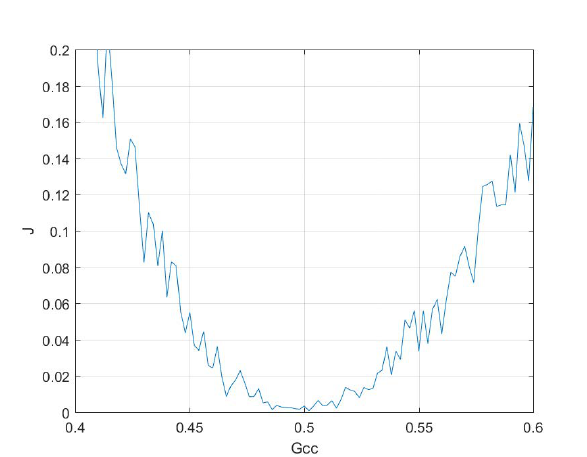
Figure 11: Identification of G cc = 0 . 5 based on model with population size N =